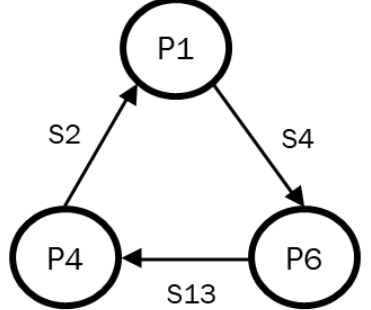
Figure 14. After adjacency, the clockwise or counterclockwise order is tested using the convex hull. The result of the convex vertexes are already counterclockwise ordered. The same process is repeated for surfaces 4, 5, 6 and 7.